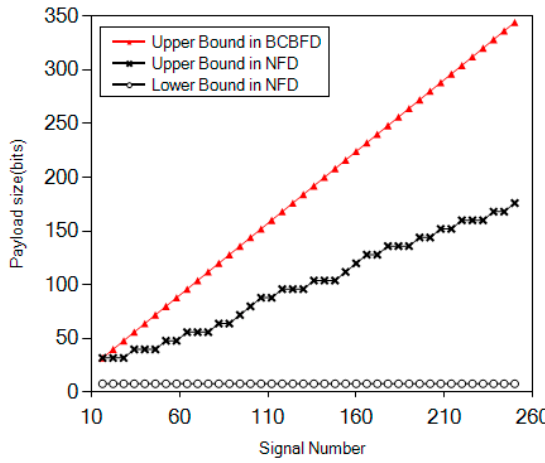
Figure 6. Bound limits of the frame payload segment.